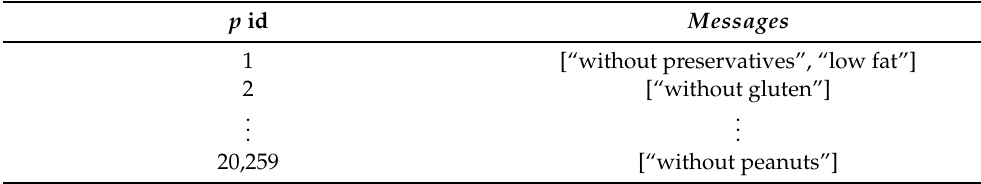
Table 13. Example of the list which contains the vectors of the features included in the Messages columns belonging to each product ( withoutlist ).